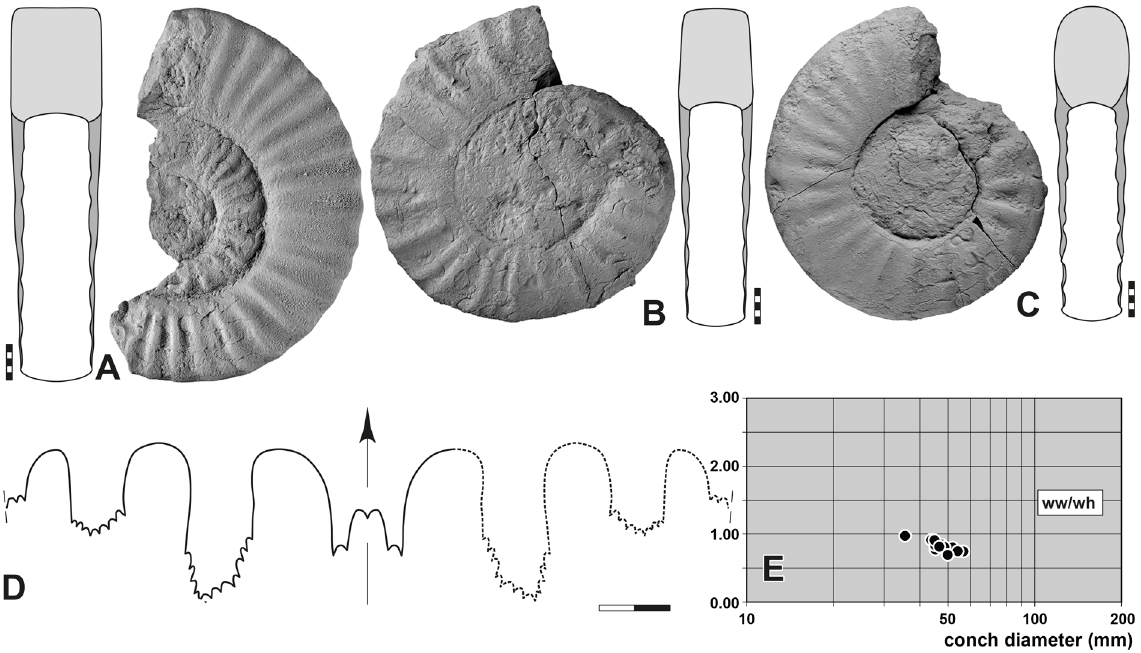
Fig. 17. Shevyrevites shevyrevi Teichert & Kummel in Teichert et al. , 1973. A . Lateral and dorsal view, specimen MB.C.29674, section E, float. B . Lateral and dorsal view, specimen MB.C.29672, section B, float. C . Lateral and dorsal view, specimen MB.C.29670, section B, float. D . Suture line, specimen MB.C.29674, at 10.8 mm ww, 13.0 mm wh. E . Whorl profile proportions. Abbreviations: see Material and methods. Scale bar units = 1 mm.